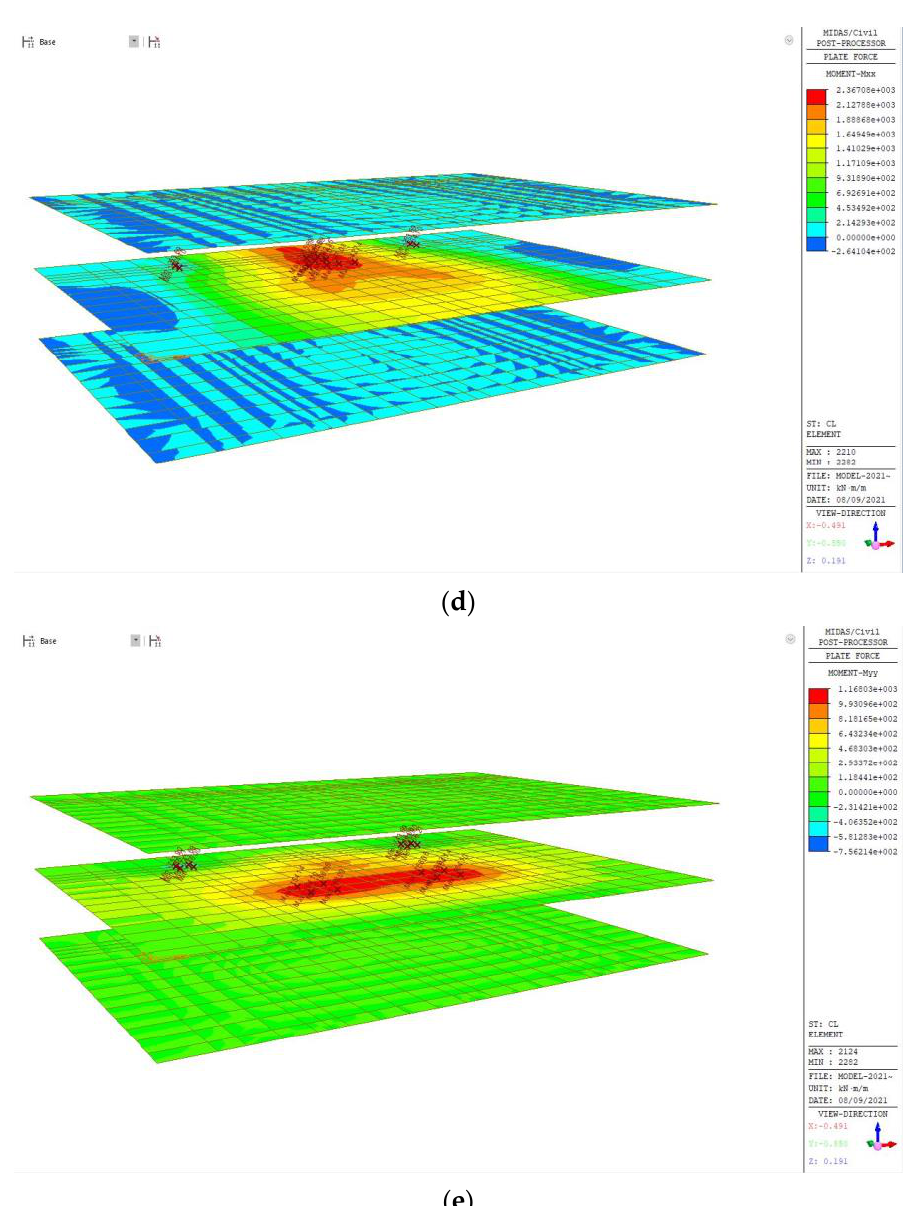
Figure 7. Plate element model for anchor block and its results. ( a ) Boundary conditions and node- connections. ( b ) Displacement results. ( c ) Shear force results ( x -axis). ( d ) Bending Moment results ( x -axis). ( e ) Bending Moment results ( y -axis).